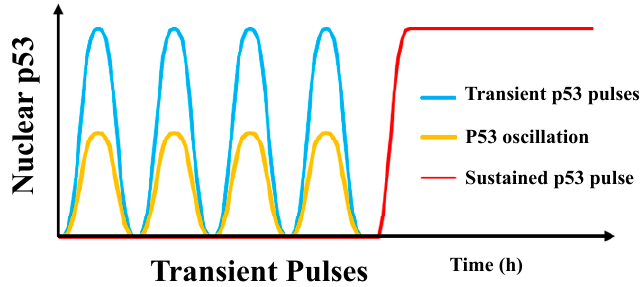
Figure 4. Different dynamic patterns of p53. p53 oscillations (yellow line) that occur at the early stage of DNA damage but with a low amplitude, constitute the basis of p53 dynamic behaviors. Transient p53 pulses (blue line) with a high amplitude occur at the early stage of DNA damage resulting in cell cycle arrest and DNA repair. Sustained p53 pulses (red line) occur at later stages of DNA damage leading to apoptosis.